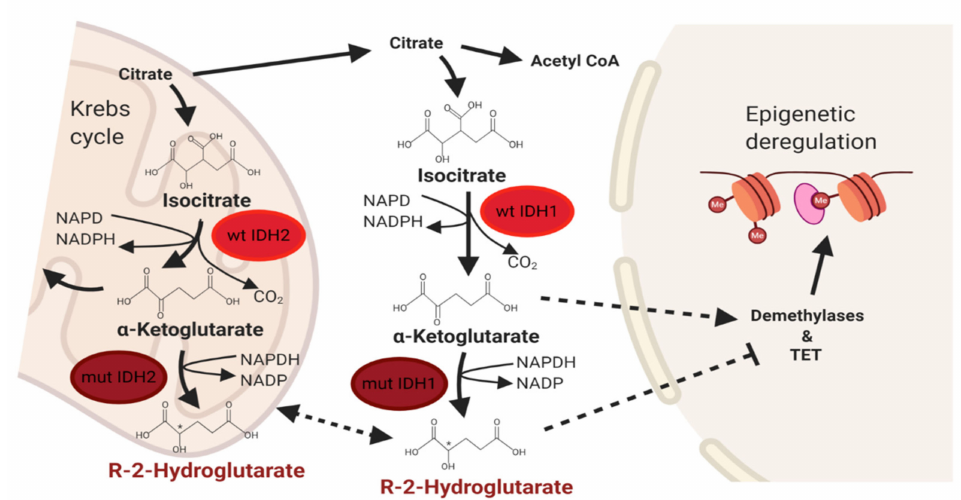
Figure 2. Normal and deregulated isocitrate dehydrogenase (IDH) signaling in cancer. Abbreviations: wt IDH1 / 2, wild-type isocitrate dehydrogenases 1 and 2; mut IDH1 / 2, mutant isocitrate dehydrogenases 1 and 2; TET, ten-eleven